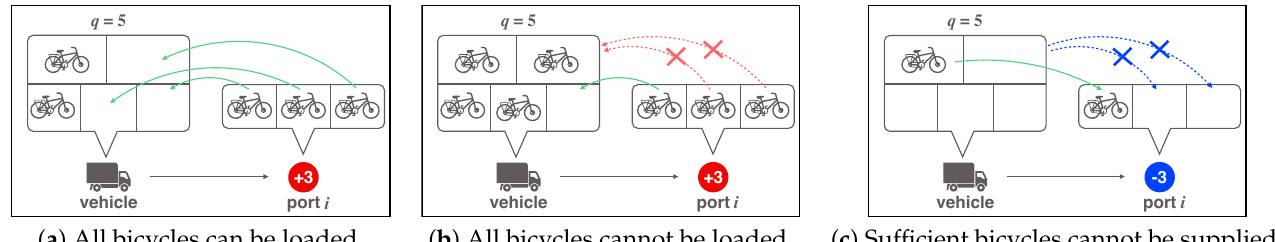
Figure 1. Examples of the loading violation and the supply violation ( a – c ). In these examples, the capacity of the vehicle is five ( q = 5). Red and blue circles indicate ports. The numerals in the circles are the shortage and excess number of bicycles. At the red port, there are three excess bicycles. Thus, the vehicle must load three bicycles. At the blue port, there is a shortage of three bicycles. Thus, the vehicle must supply three bicycles; however, only one bicycle is supplied in this